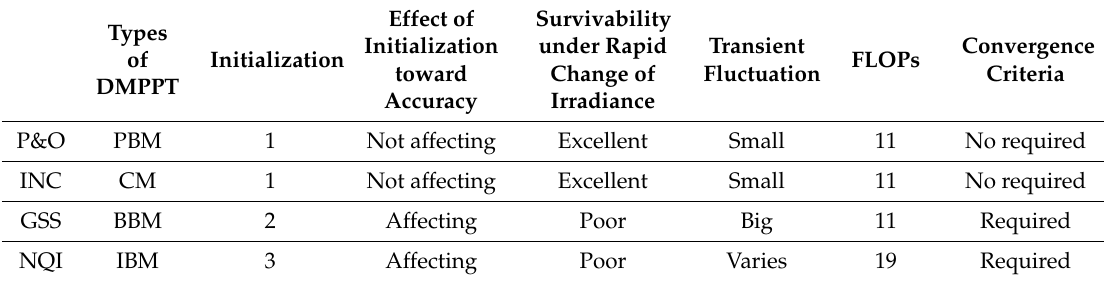
Table 2. Characteristics of the four DMPPT